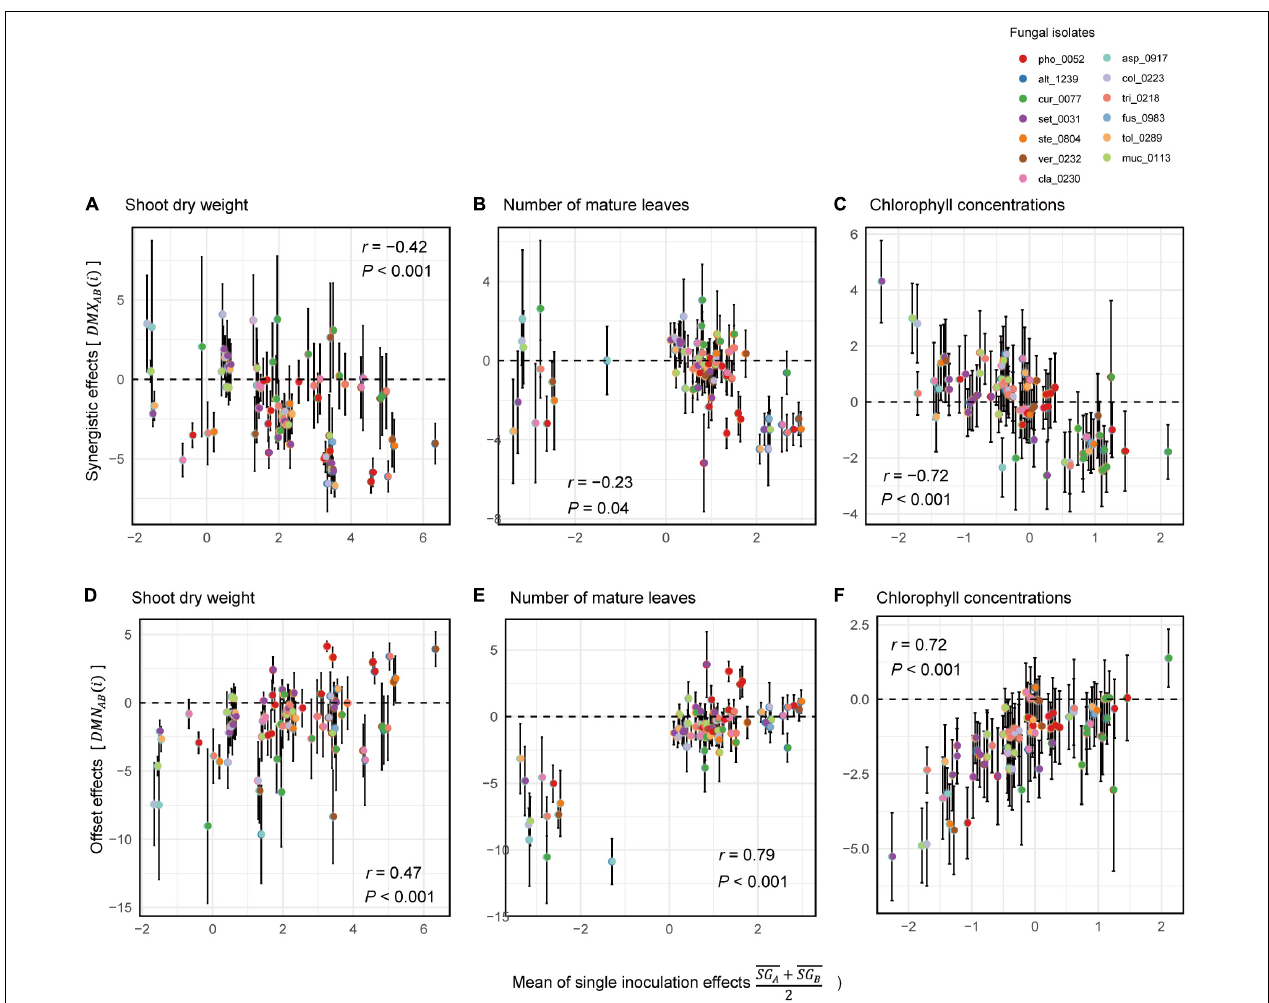
FIGURE 6 | Relationship between single-inoculation effects and synergistic/offset effects. (A) Trends in synergistic effects in terms of shoot dry weight. For each pair of fungi, mean values of single inoculation effects of the target fungi (i.e., SG A + SG B 2 ) and index values of synergistic effects [i.e., DMX AB ( i ) ] are shown at the horizontal and vertical axes, respectively. Error bars represent standard deviations of synergistic effects. (B) Trends in synergistic effects in terms of the number of mature leaves. (C) Trends in synergistic effects in terms of chlorophyll concentrations. (D) Trends in synergistic effects in terms of shoot dry weight. For each pair of fungi, mean values of single inoculation effects of the target fungi (i.e., SG A + SG B 2 ) and index values of offset effects [i.e., DMN AB ( i ) ] are shown at the horizontal and vertical axes, respectively. (E) Trends in synergistic effects in terms of the number of mature leaves. (F) Trends in synergistic effects in terms of chlorophyll